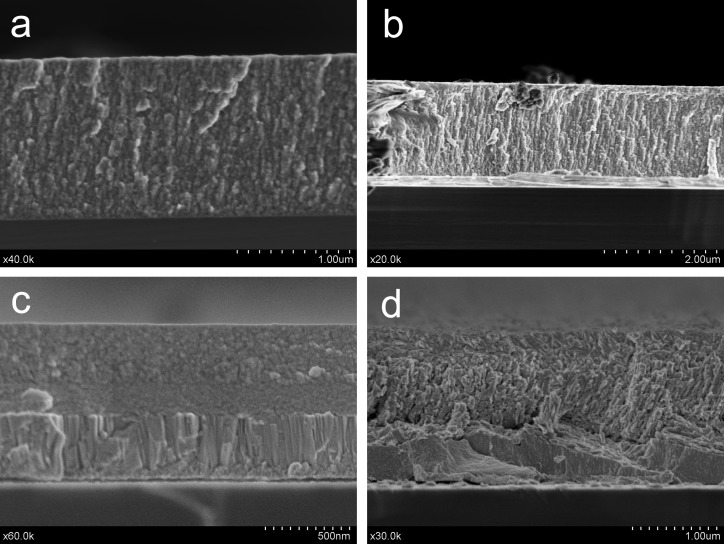
SEM cross-sectional views of the MoS2 and WSe2-based coatings: (a) MoS2, (b) MoS2-WC, (c) WSex, (d) WSex-WC.